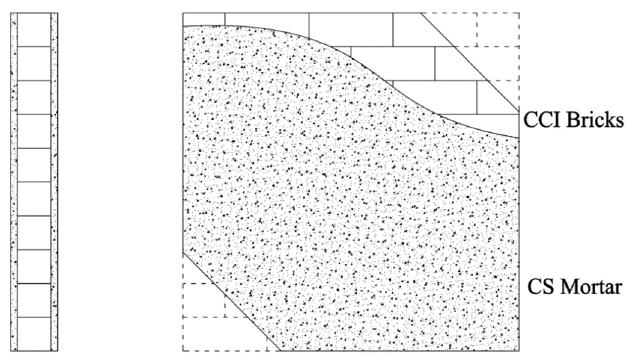
Figure 7. The application of CEMENT mortar on CCI bricks.